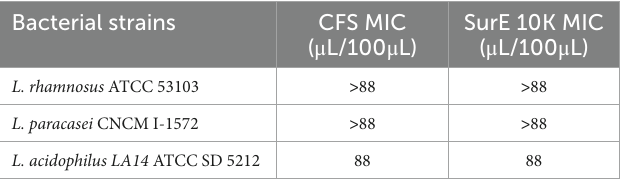
TABLE 2 Quantitative results obtained from the NMR analysis of samples subtracted from their blank (MRSB). Metabolite